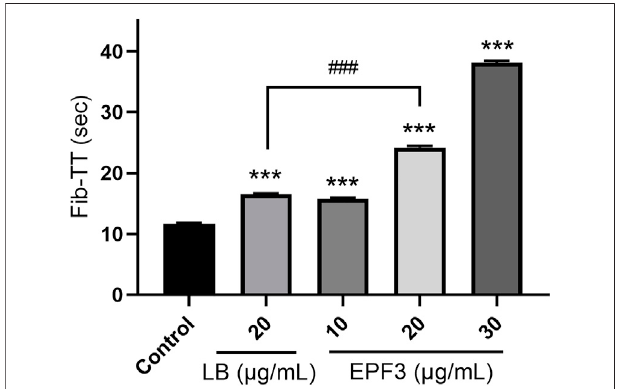
FIGURE6| TheFib-TTofEPF3comparedwithlumbrokinase( n (cid:1) 3).***, p < 0.0001comparedwithcontrol; ### ,p < 0.0001EPF3(20 μ g/ml)compared with lumbrokinase (20 μ